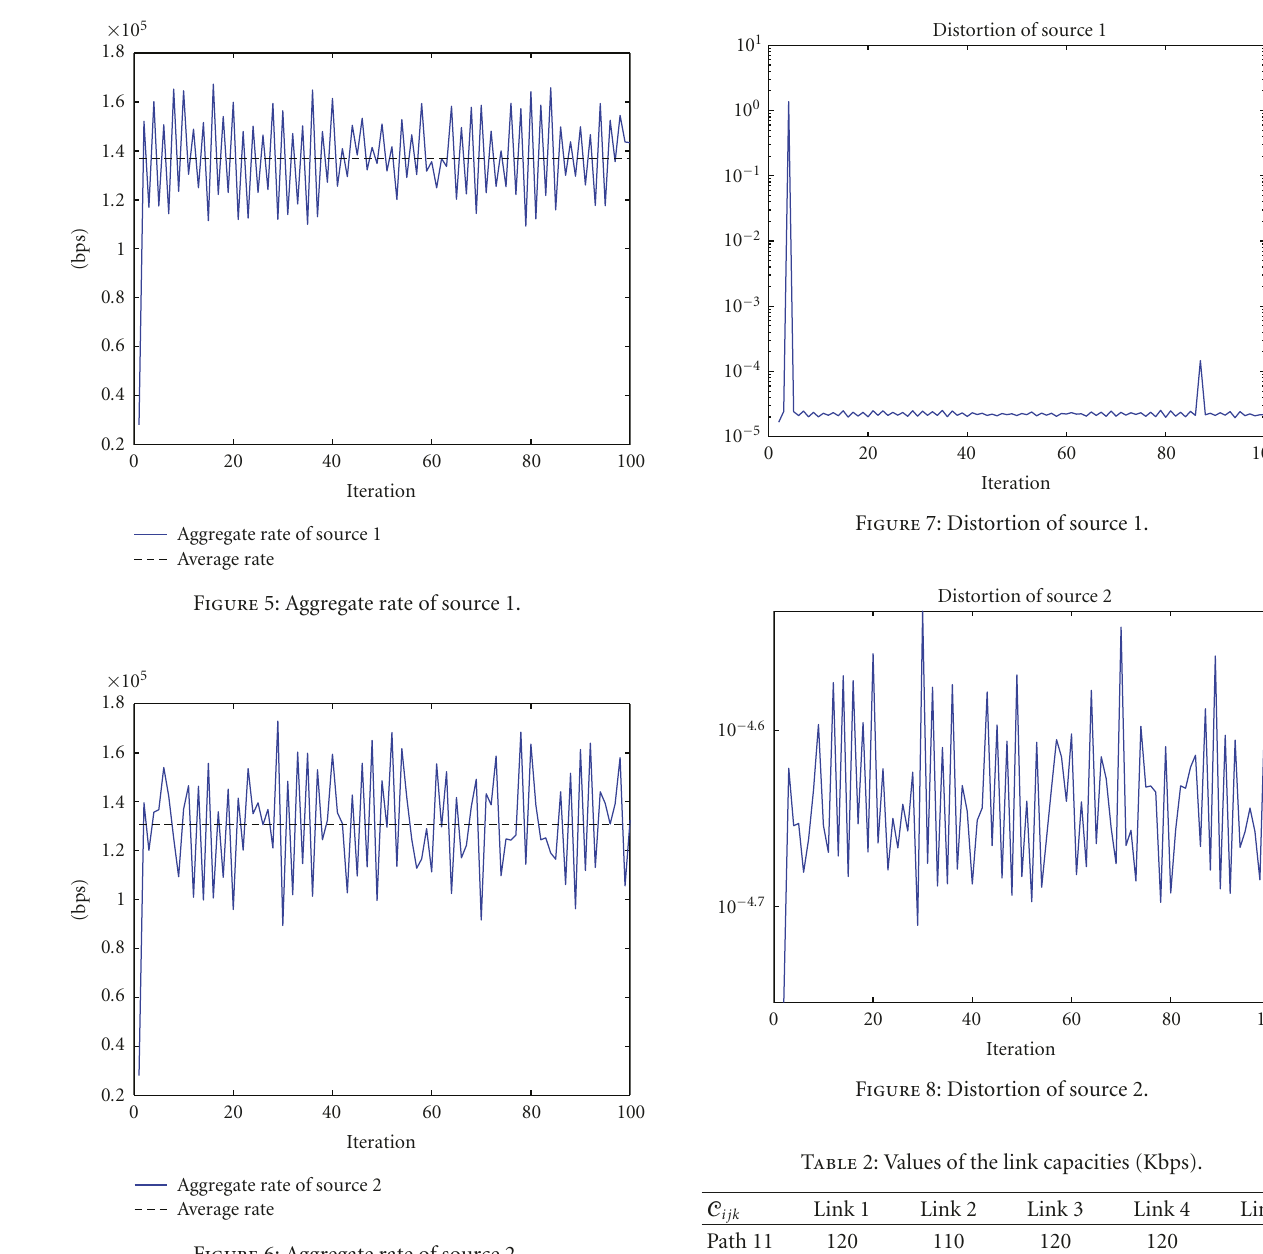
Figure 6: Aggregate rate of source 2. Table 1: Values of the parameters η ij .